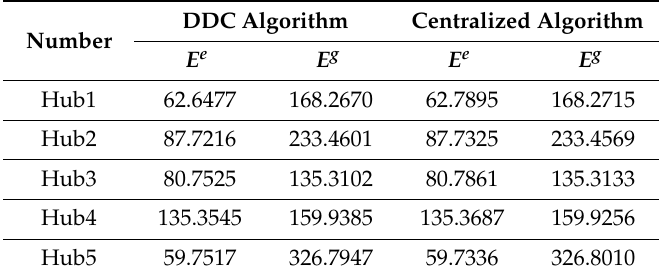
Figure 4. Comparison with centralized algorithm: ( a ) the electricity mismatch; ( b ) the heat mismatch; ( c ) the electricity multiplier; ( d ) the heat multiplier; ( e ) electricity input; ( f ) gas input. Table 2. Comparison with centralized